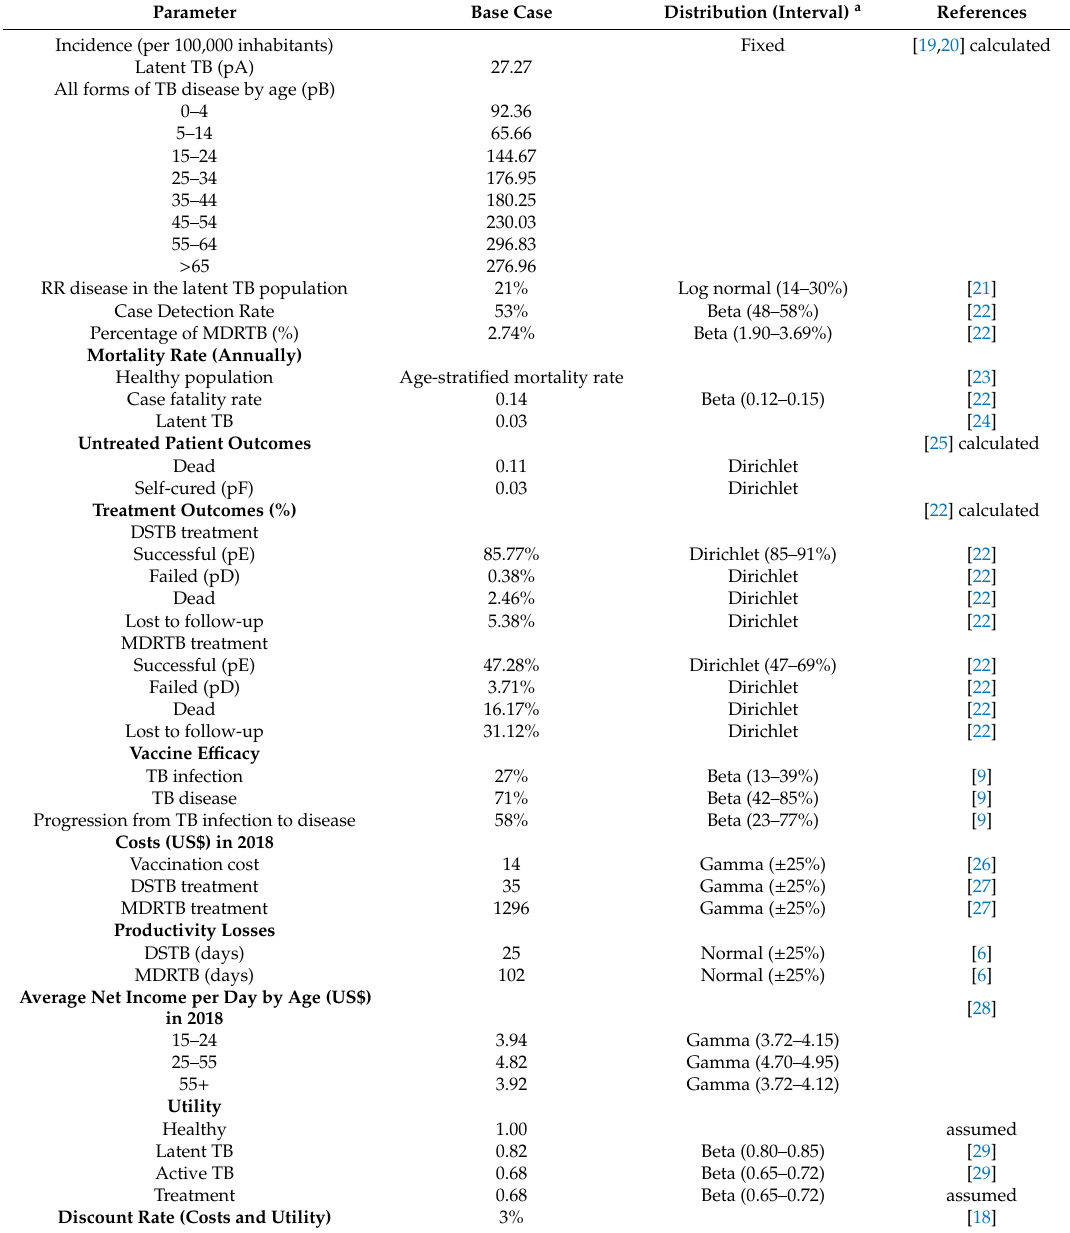
Table 1. Input parameters used in the